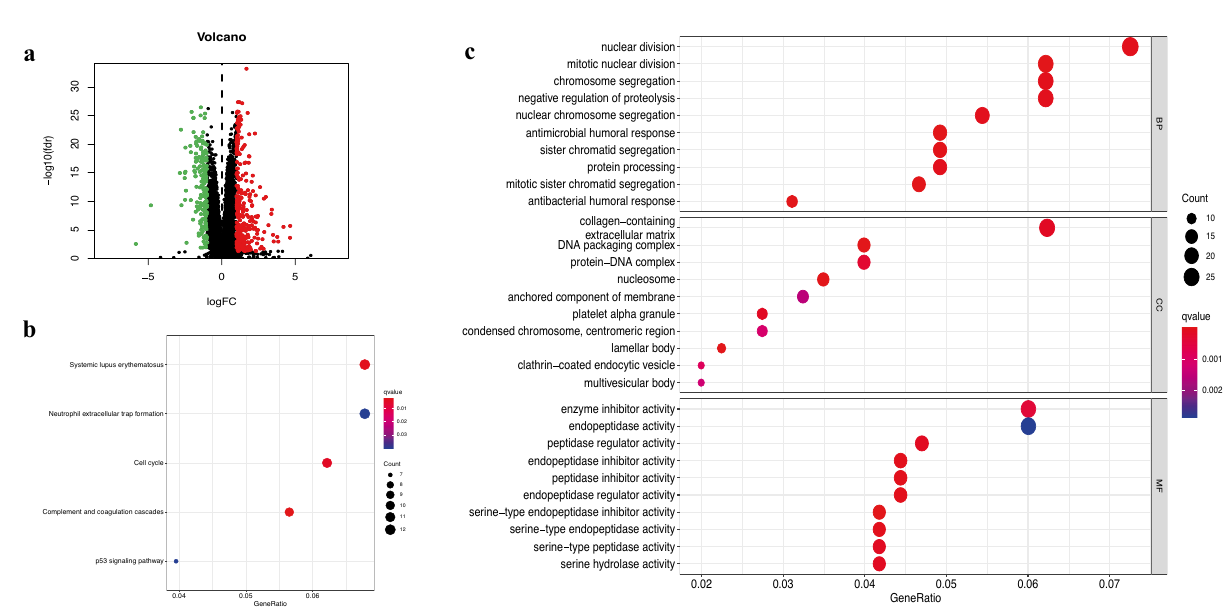
Figure 5. DEGs and enrichment analysis between the distinct risk populations ( a ) Volcano map of DEGs between two groups. ( b ) KEGG analysis of DEGs. ( c ) GO analysis of